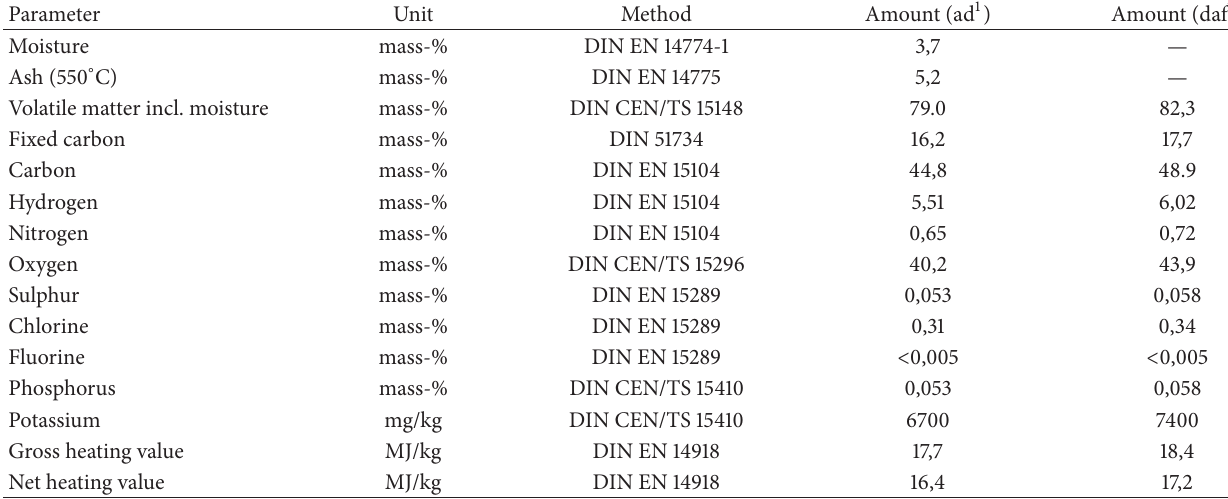
Table 1: Proximate and ultimate analysis of wheat straw [22].